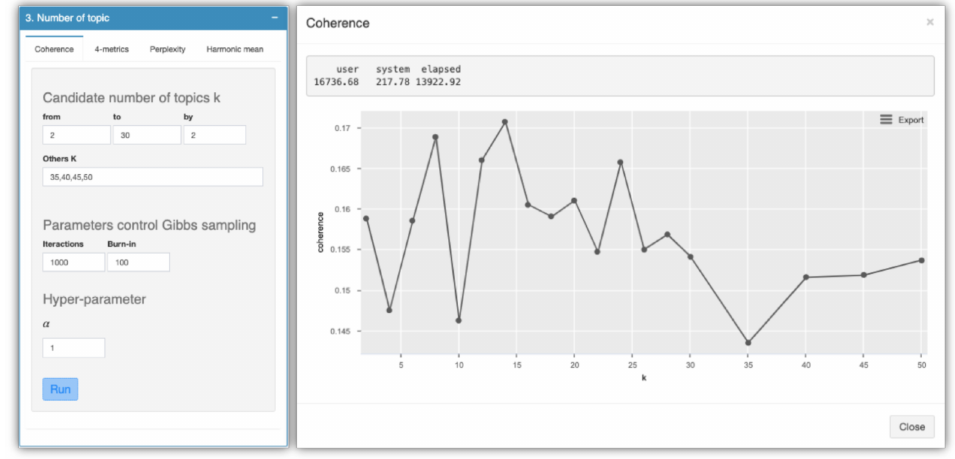
Figure 4. Configuration options used to calculate the number of topics (coherence method).